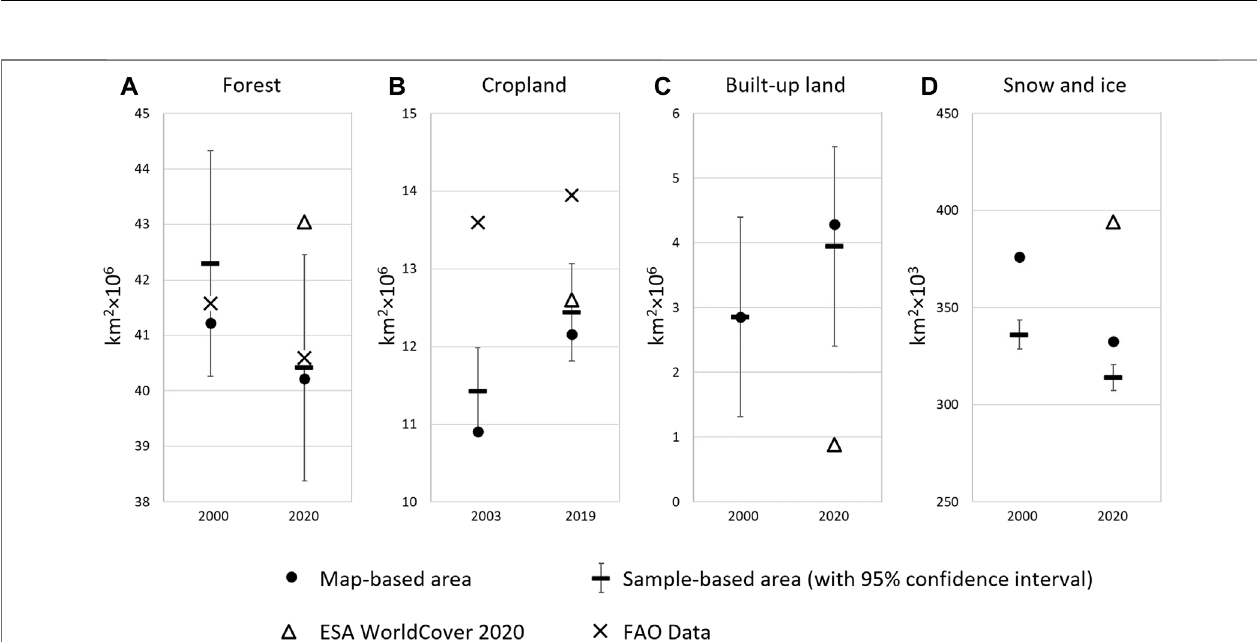
FIGURE 9 | Global LCLU class areas from different data sources. (A) forest extent; (B) croplands; (C) built-up lands; (D) perennial snow and ice. Map-based estimates are from the thematic map time series and ESA WorldCover 2000. Sample-based estimates are from the reference data. FAO data represent years 2000